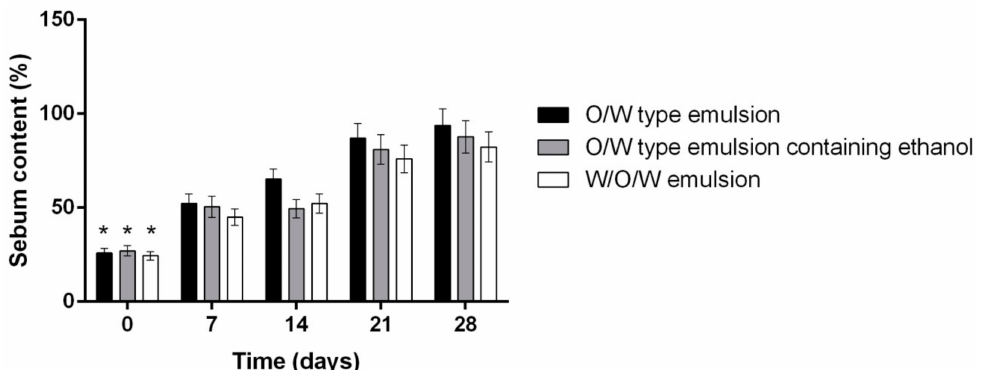
Figure 5. The influence of investigated emulsion on the skins sebum content. * p < 0.05 vs. 7, 14, 21, 28 days. N = 42 volunteers.